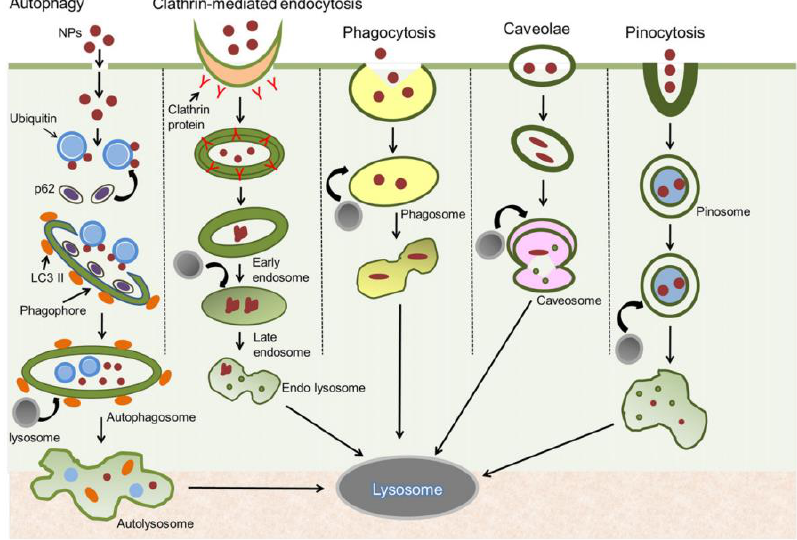
Figure 2. Schematic representation of plausible methods of cellular uptake of AgNPs [243]. Reprinted with permission from [243]. Elsevier, 2015.